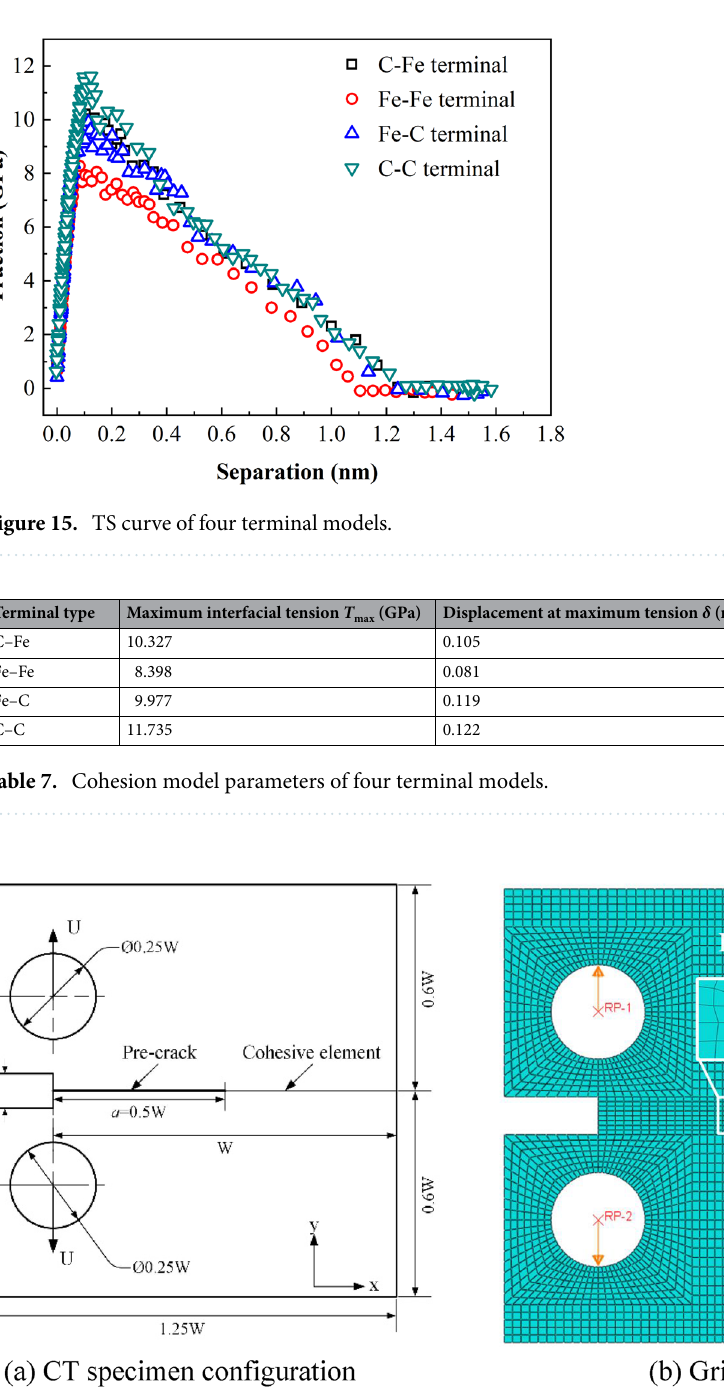
Figure 16. Schematic diagram of CT model.